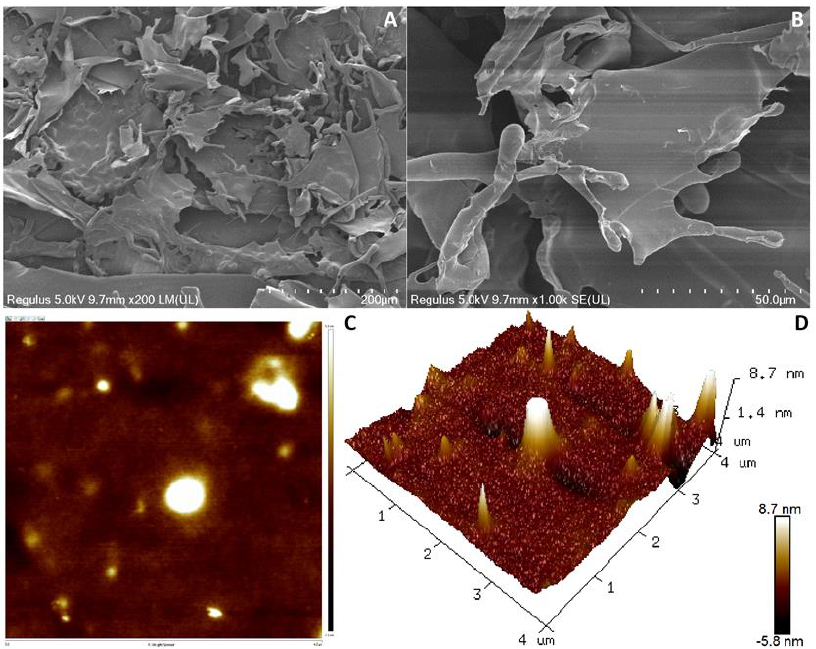
Figure 4. SEM and AFM showing the surface morphology and morphological features of dextran. ( A ) ×400 magnification of SEM; ( B ) ×2000 magnification of SEM; ( C ) planar view of AFM; ( D ) cubic view of AFM.